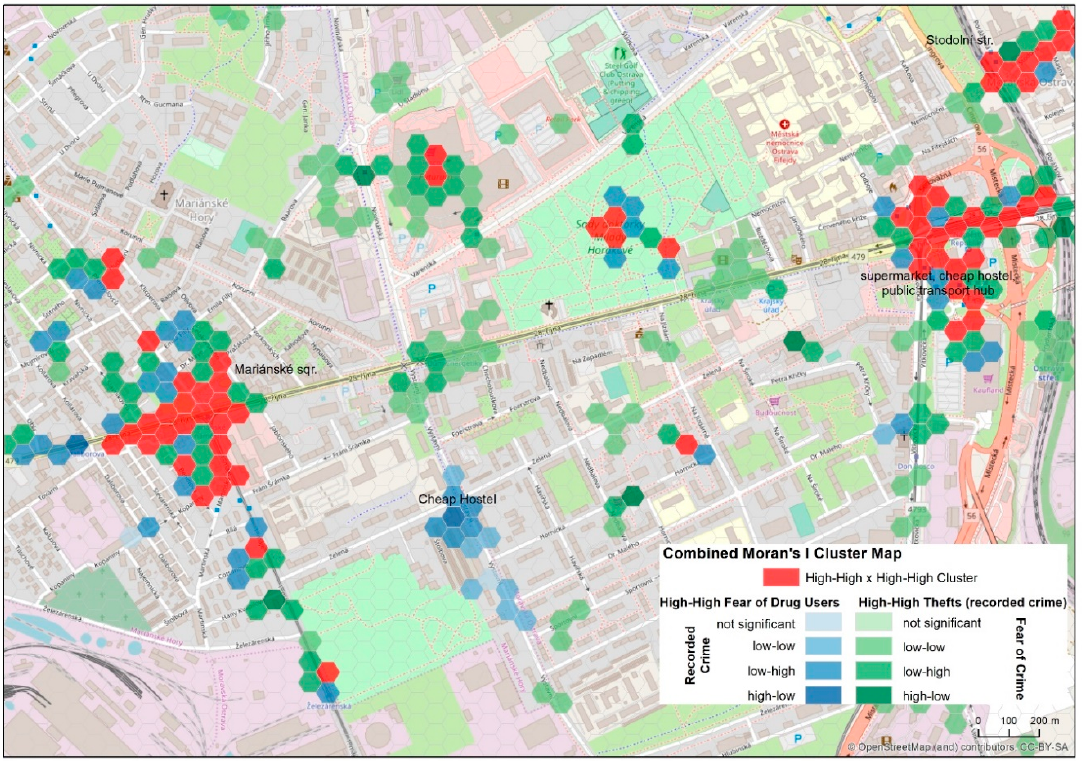
Figure 5. Cluster map comparing fear of being attacked by a drunk or drug addicted person(s) and personal thefts (recorded crime).